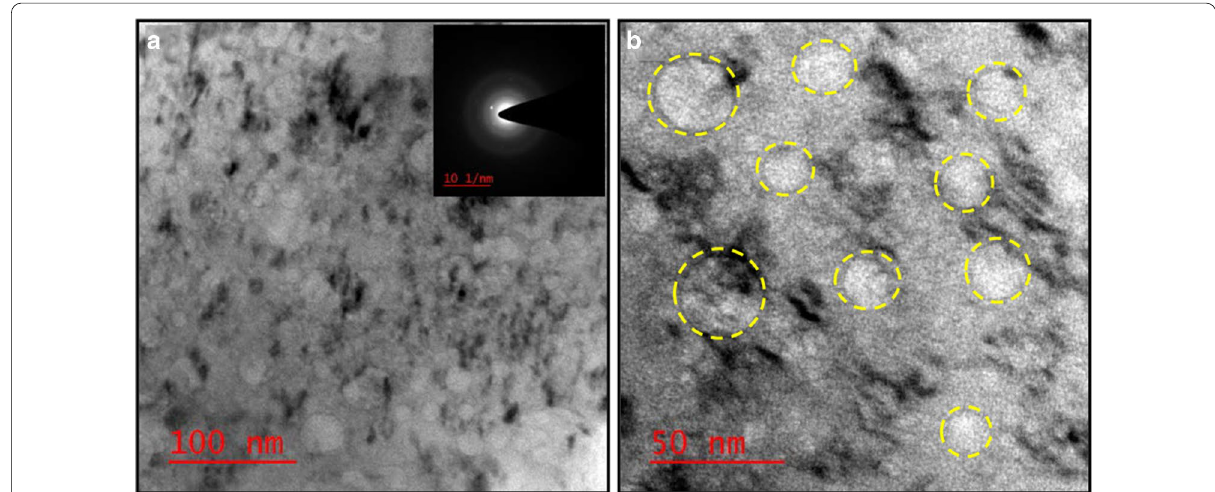
Fig. 4 a TEM image (bar scale 100 nm) (inset: SAED pattern), b TEM image showing various sizes of porous structures (bar scale 50 nm) of the as-synthesized activated carbon material